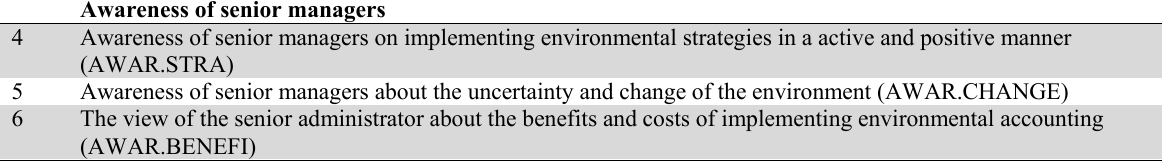
The Items of the second hypothesis: